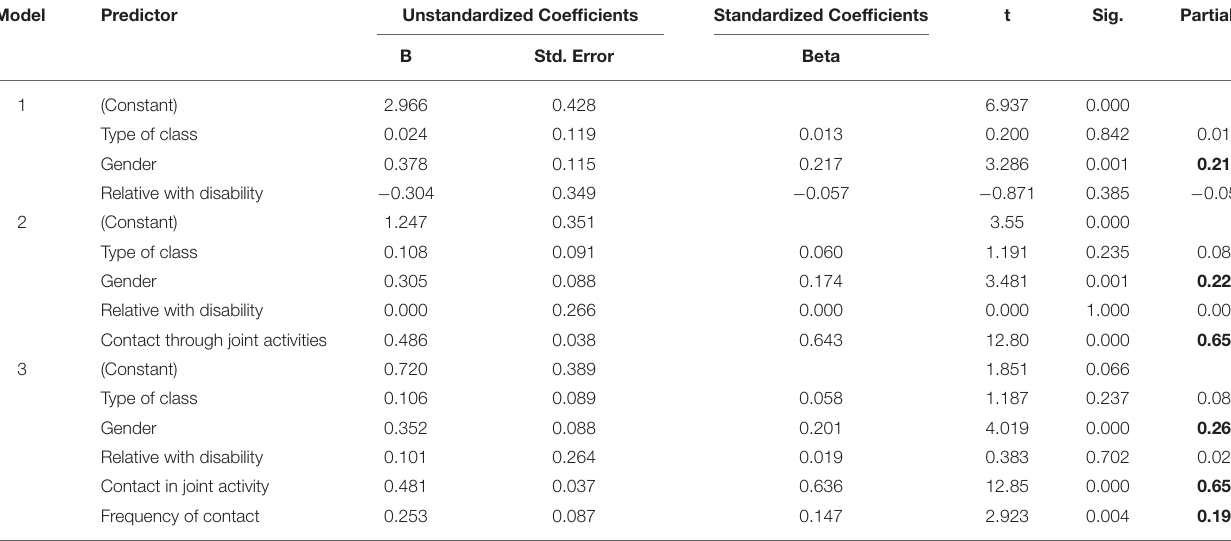
TABLE 3 | Multiple regression models to predict attitudes of students with relatives with disabilities n = 221. Model